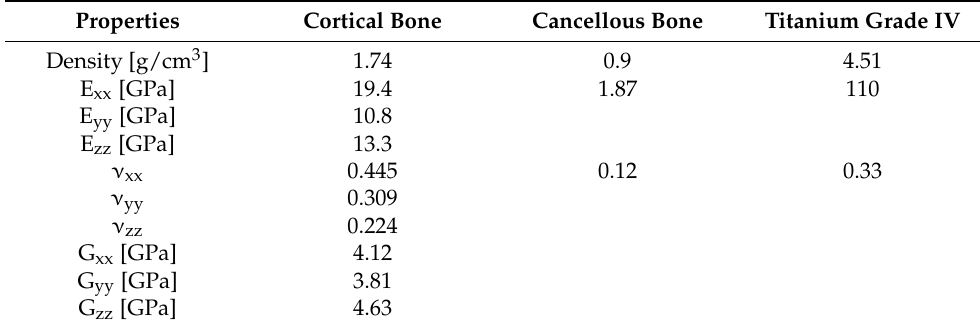
Table 1. Material properties.